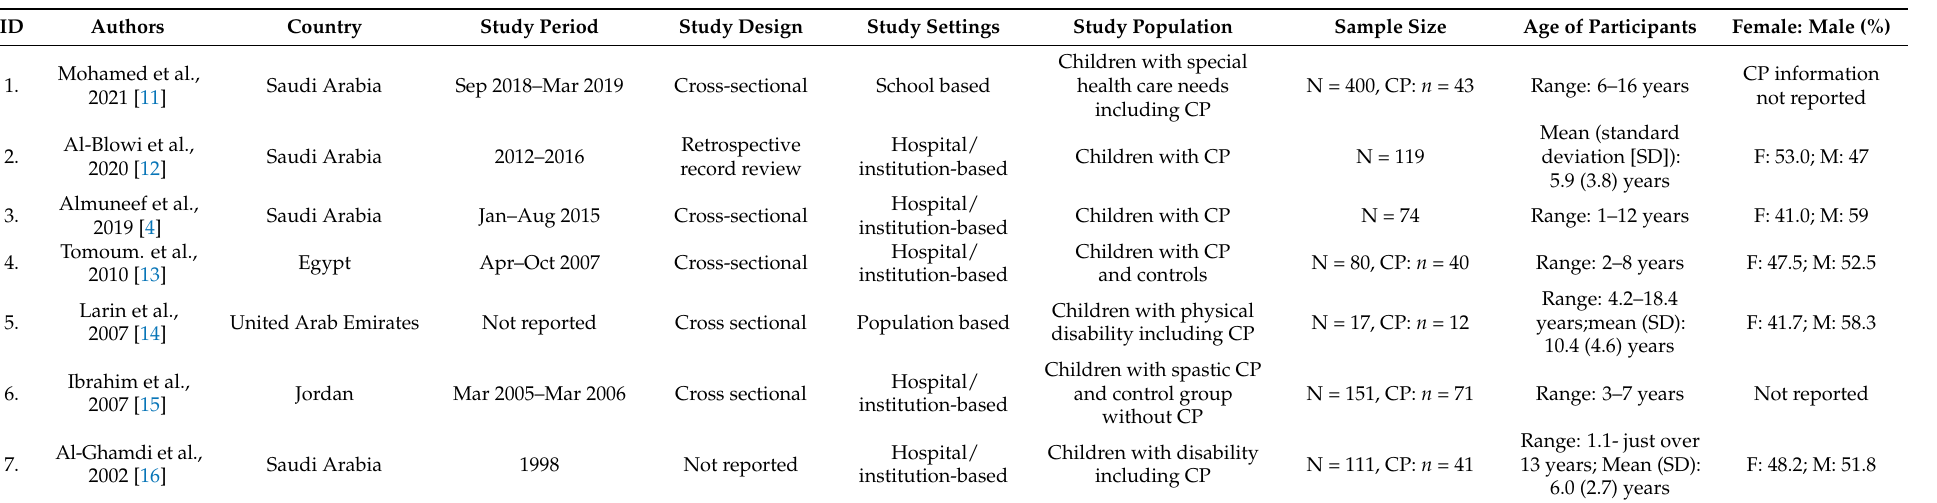
Table 3. Summary of characteristics of included